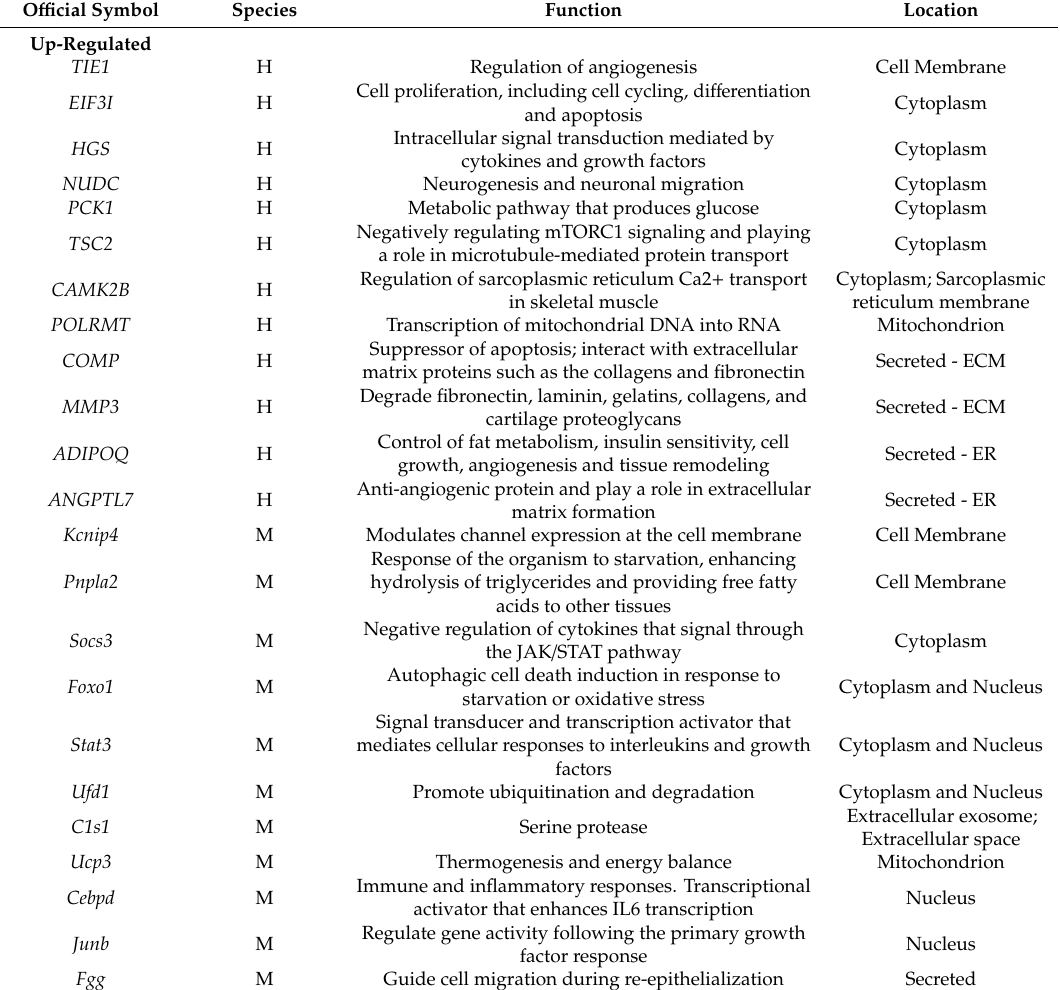
Table 2. List of 52 di ff erentially expressed genes of skeletal muscle in cancer cachexia